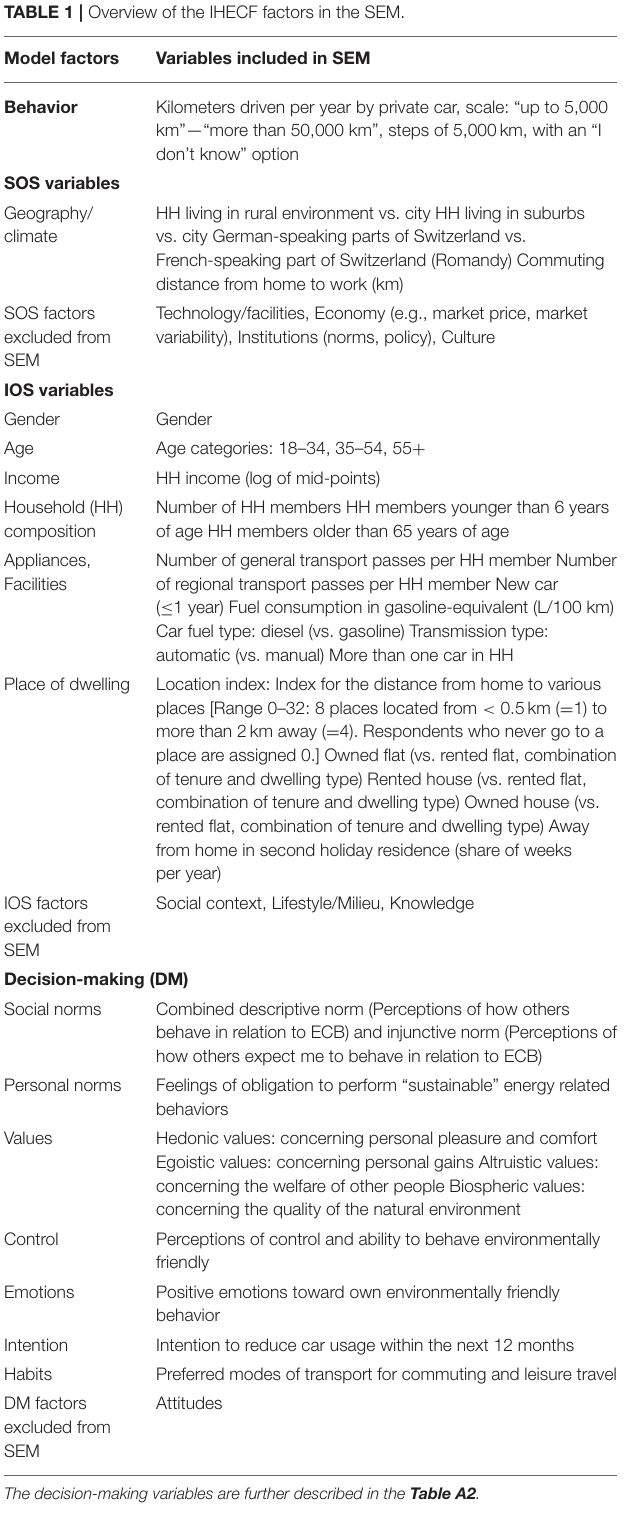
TABLE 1 | Overview of the IHECF factors in the SEM. Model